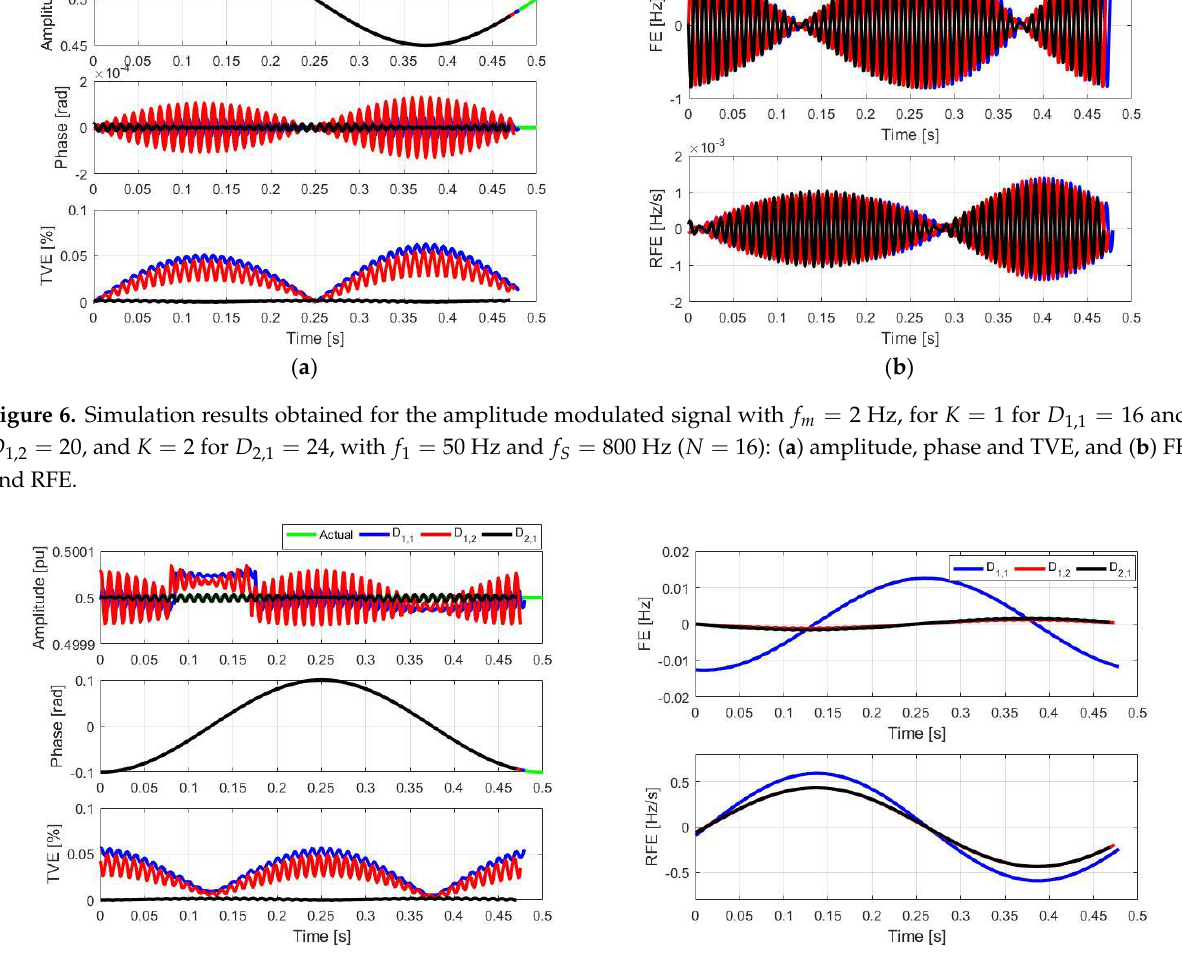
Figure 6. Simulation results obtained for the amplitude modulated signal with 𝑓 𝑚 = 2 Hz , for 𝐾 = 1 for 𝐷 1,1 = 16 and 𝐷 1,2 = 20 , and 𝐾 = 2 for 𝐷 2,1 = 24, with 𝑓 1 = 50 Hz and 𝑓 𝑆 = 800 Hz ( 𝑁 = 16 ): ( a ) amplitude, phase and TVE, and ( b ) FE and RFE.